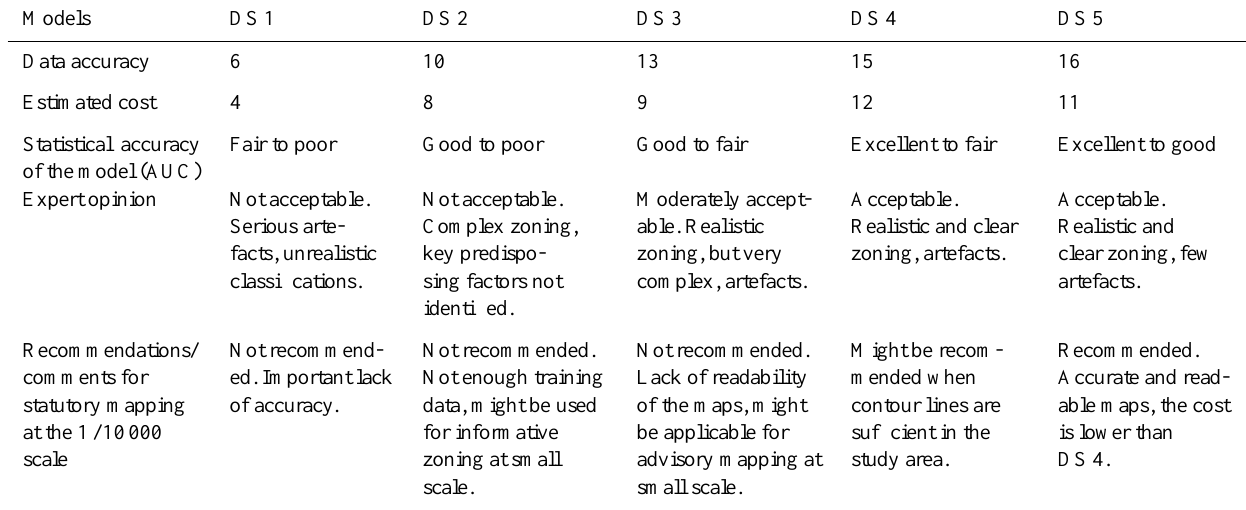
Table 8. Cost/accuracy analysis, quality of the model and comments and suggestions for the operational mapping of the five models. (The value of the data accuracy and estimated cost rows is obtained by the sum of the “+” symbols displayed in Table 1 according to the